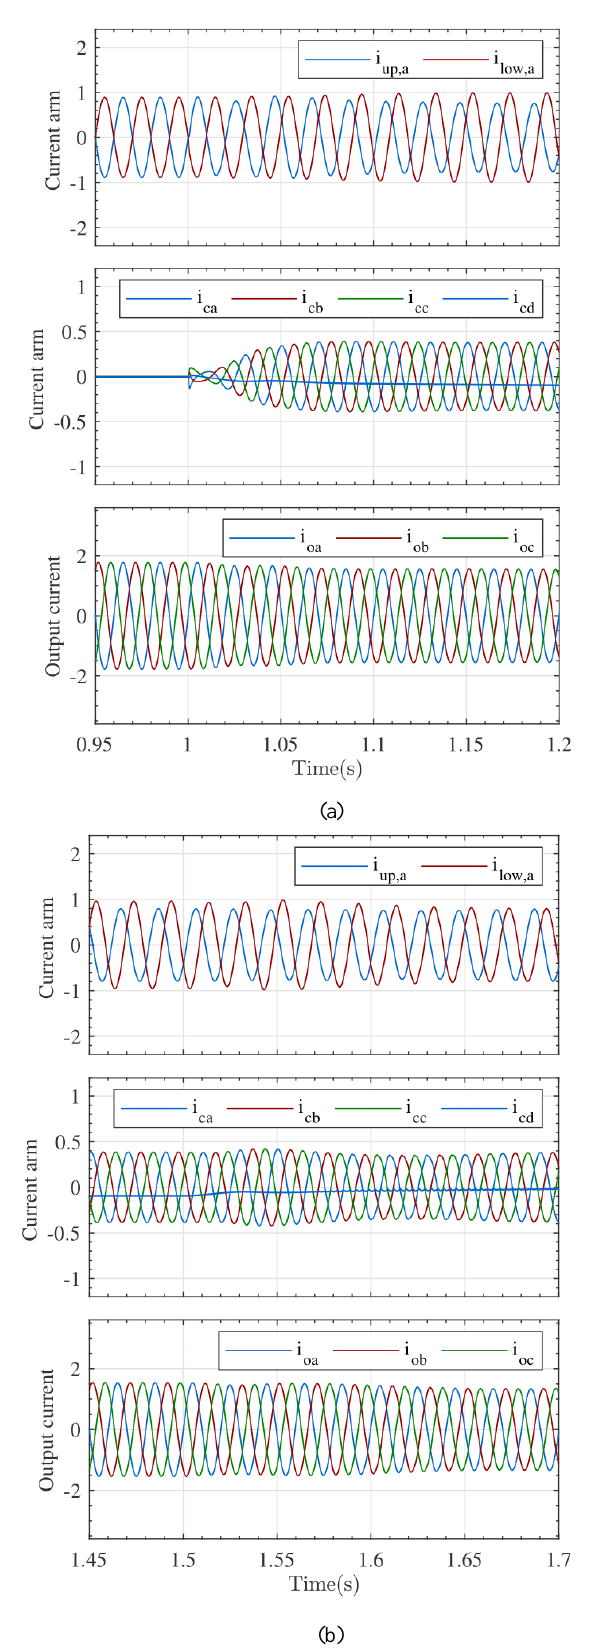
Figure 10. Current arms, circulating current, and output current. ( a ) First event, ( b ) second